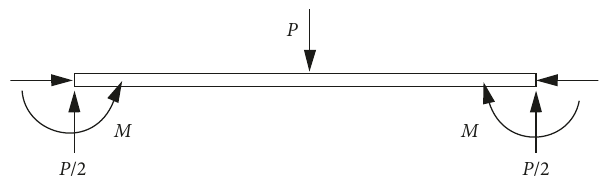
Figure 4: The force diagram of a supporting